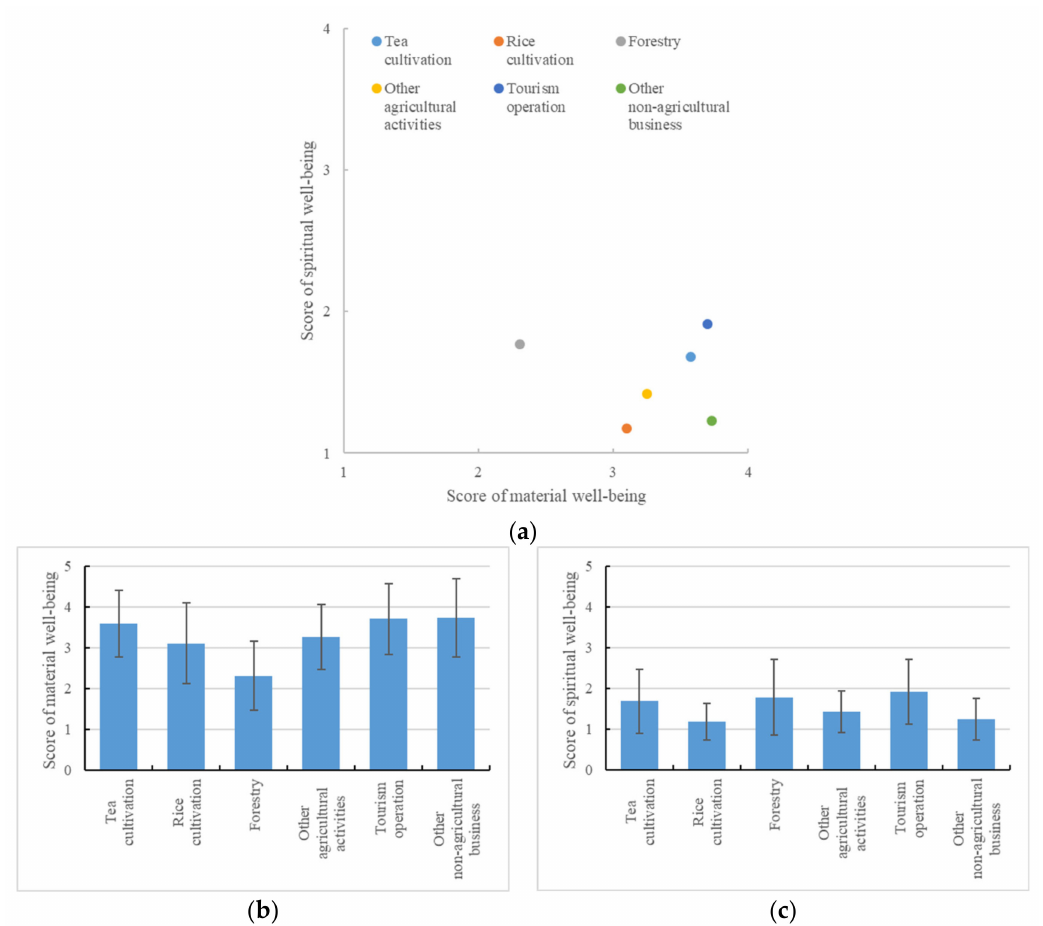
Figure 6. Perception of well-being among households of different livelihood strategies. The relationship between material well-being and spiritual well-being ( a ); scores of material well-being ( b ); scores of spiritual well-being ( c